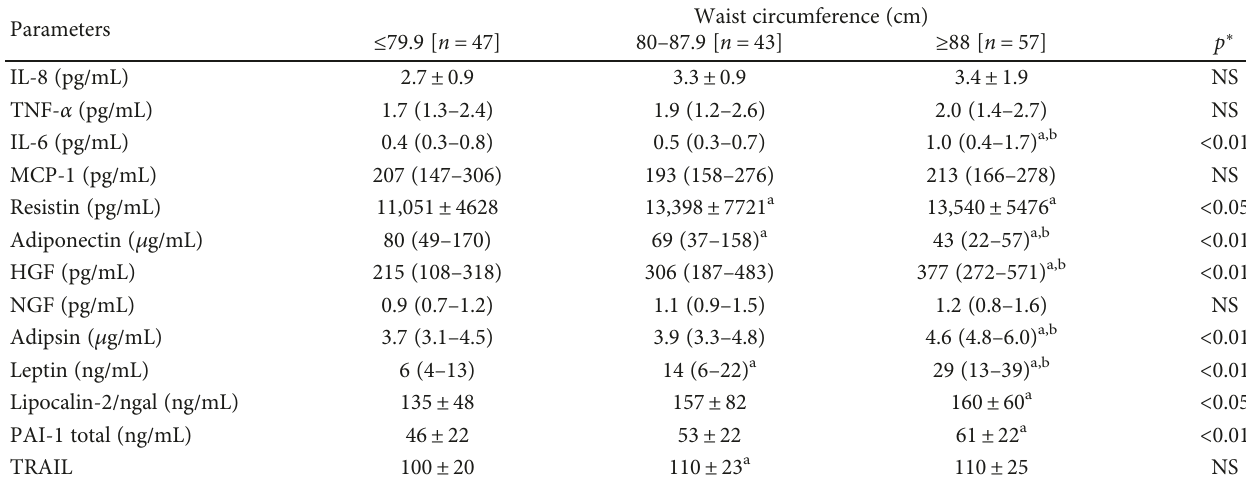
Table 2: Serum levels of adipokines and TRAIL according to abdominal obesity categories. Parameters